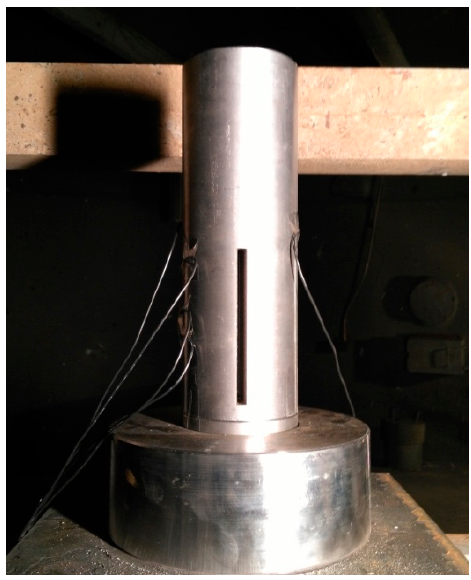
Figure 4. Photograph of experimental steel body.